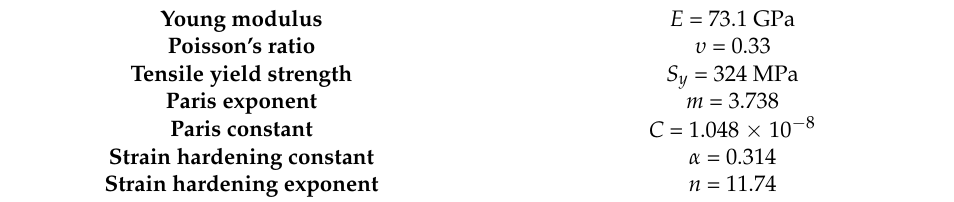
Table 2. Material properties of 2024-T4 aluminum alloy.